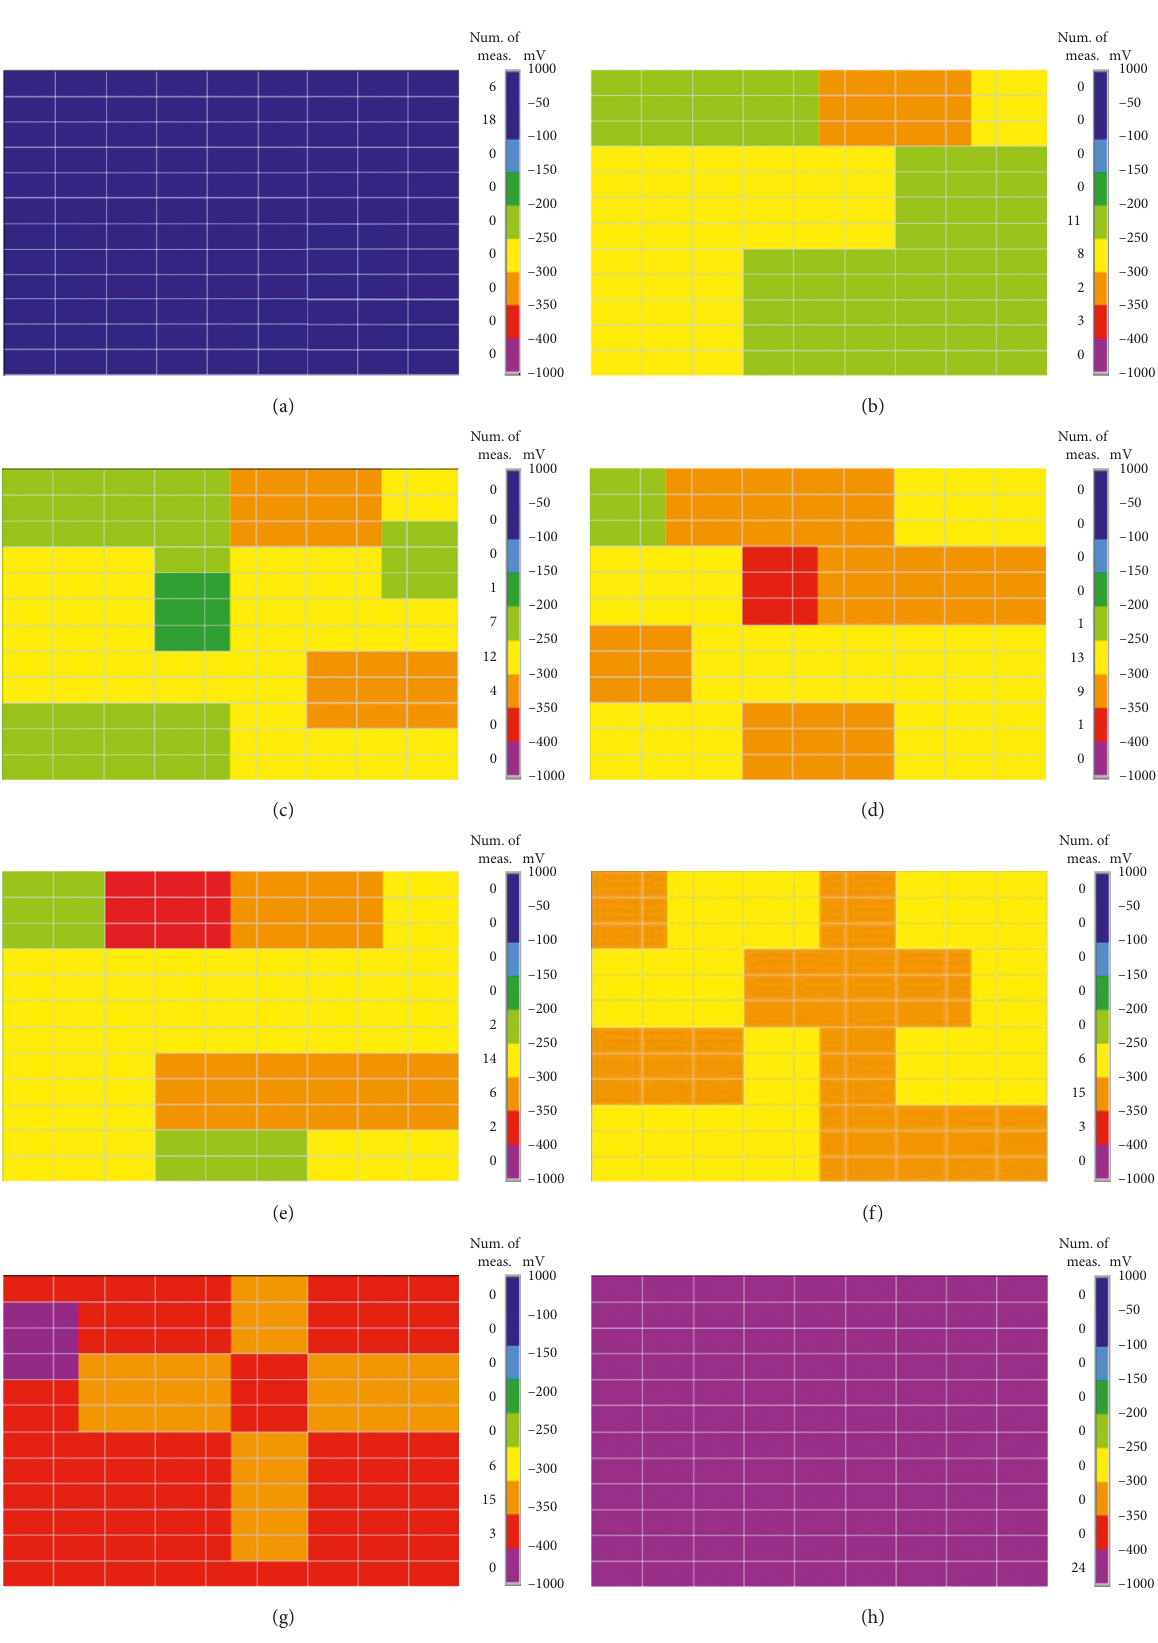
Figure 8: Potential map of beams controlled by flexure: (a) FB-C0, (b) FB-C1, (c) FB-C2, (d), FB-C3, (e) FB-C4, (f) FB-C5, (g) FB-C6, and (h)